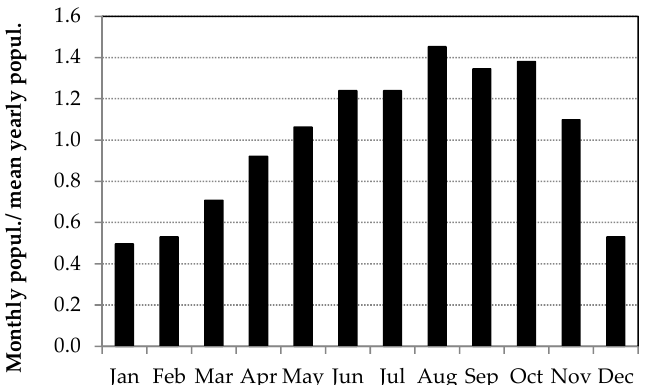
Figure 1. Monthly population normalized to mean yearly population for the island of Lipari.